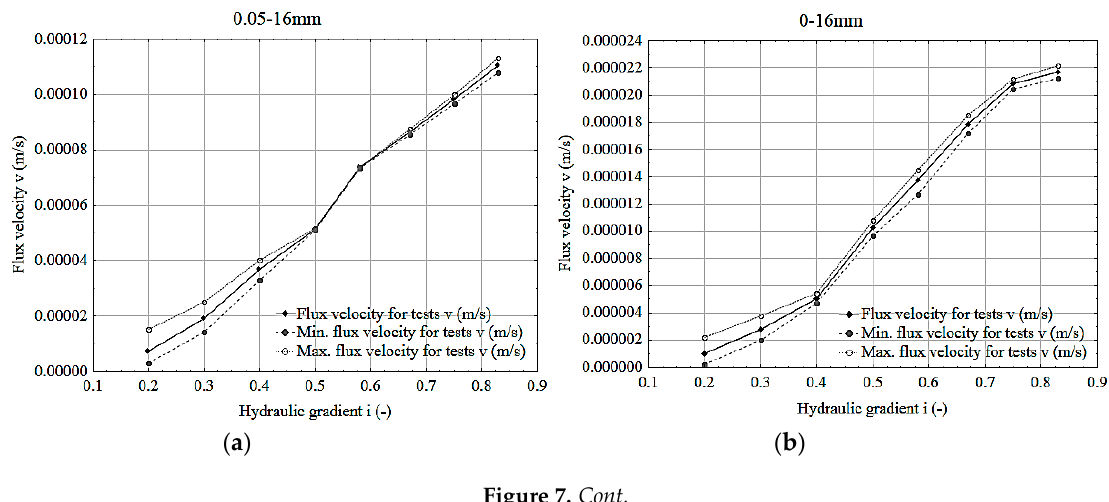
Table 2. Estimated errors of the flux velocity measurements for each of the gradients and